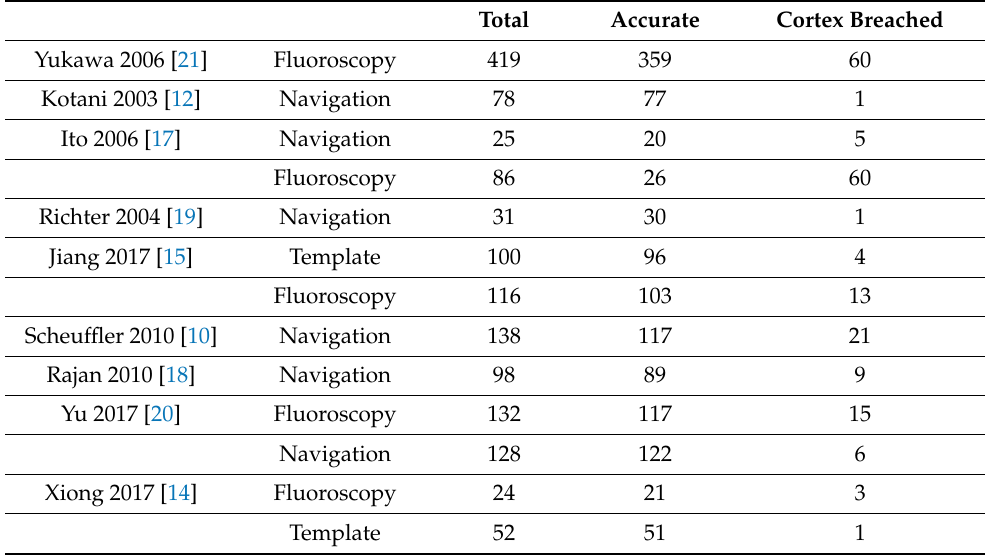
Table 2. Summary of all the trials included in the systematic review and the